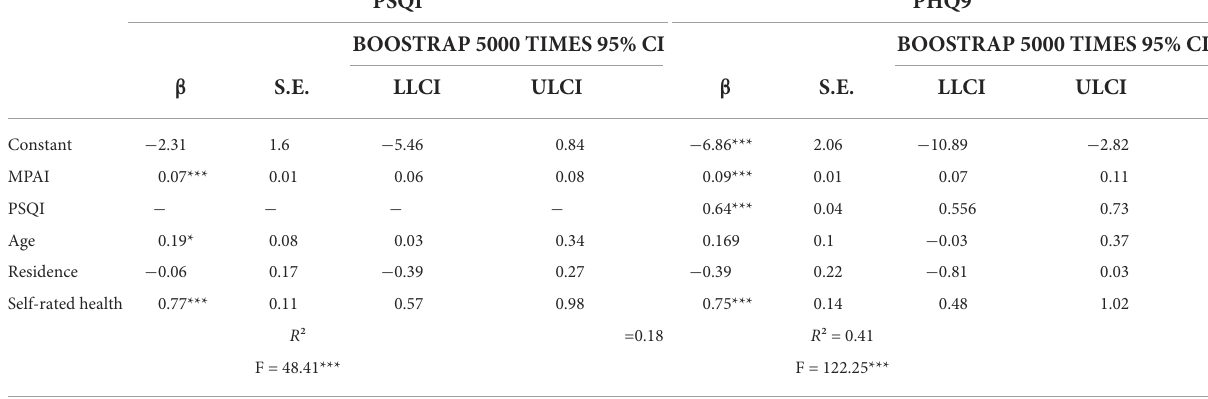
TABLE 3 Testing the mediation model of sleep